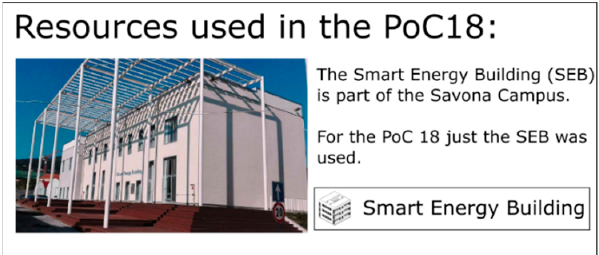
Figure 10. Smart Energy Building (SEB) in Savona Campus (Genoa University, Seville).